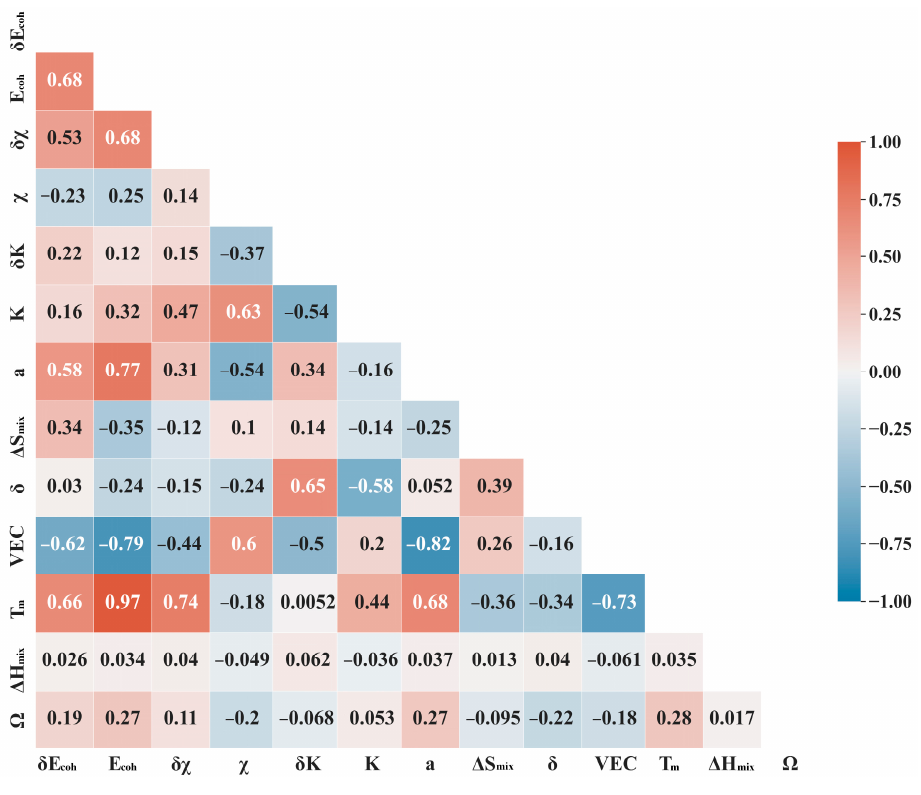
Figure 2. Heat map of inter-feature correlation by correlation analysis.